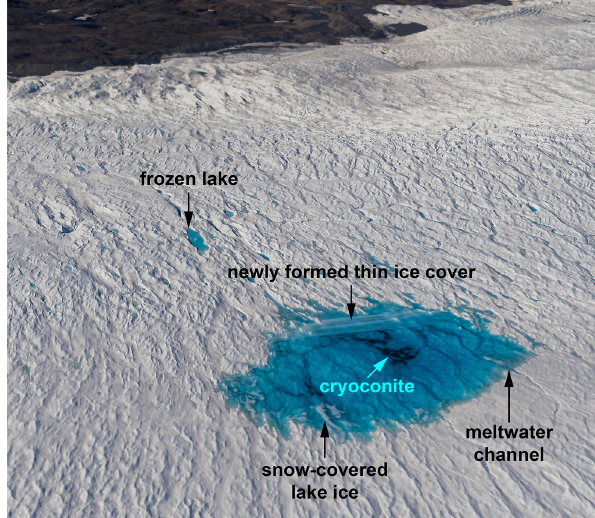
Figure 1. Oblique aerial photograph of a supraglacial lake (approx- imate location 67 ◦ 12 (cid:48) 38 (cid:48)(cid:48) N, 49 ◦ 54 (cid:48) 46 (cid:48)(cid:48) W) on Isunnguata Sermia near Kangerlussuaq from 13 May 2019 (photo: Michael Studinger). The lake is approximately 280m wide. For location see Fig. 2. Surface temperature and surface melt indicator from the Moderate Resolution Imaging Spectroradiometer (MODIS) (Hall et al., 2018; Hall and DiGirolamo, 2019), as well as number of melt days for this location, are shown in Fig.